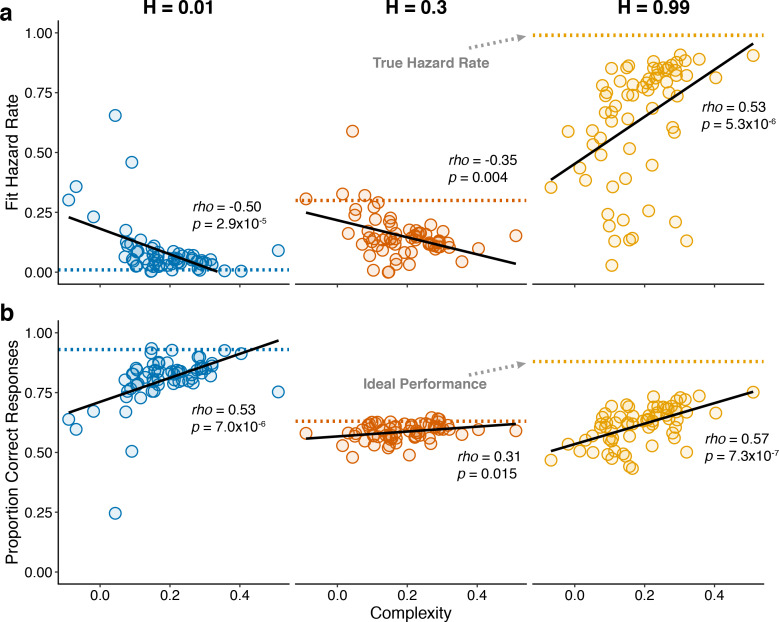
Individual differences in within-hazard performance reflected differences in belief-updating complexity.The two panels show complexity (abscissa) compared to: (a) subjective hazard rate determined from fits of the normative choice model (colored dotted lines correspond to objective hazard-rate values), and (b) proportion correct responses (colored dotted lines correspond to mean proportion correct responses from the Bayesian learning model with a wide prior over hazard rate). Points are data from individual subjects. Lines are linear fits. Note that subjective hazard rates and overall performance were relatively more variable and further from normative values for the high versus low and intermediate hazard-rate conditions.